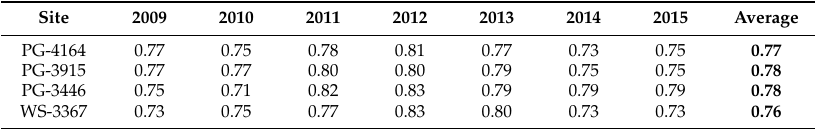
Table 2. Inter-annual and regional variation of PCD during